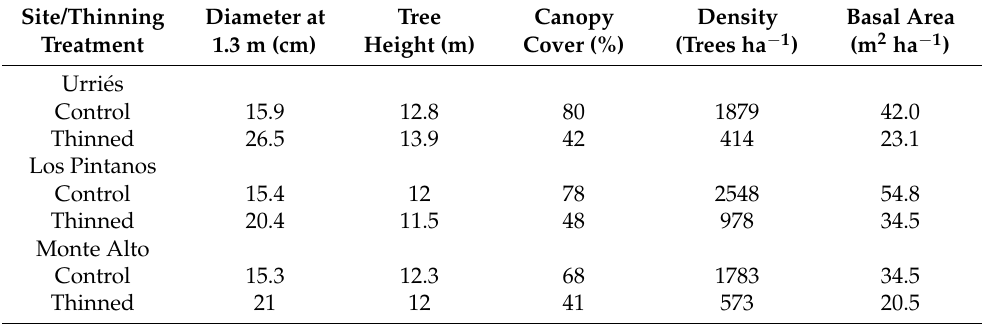
Table 1. Pinus nigra plots characteristics in the three study sites before and after